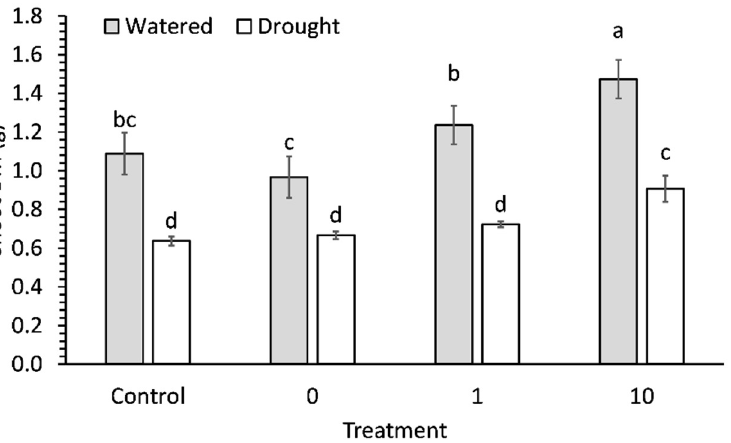
Figure 2. Shoot biomass in 9-week-old broccoli seedlings that were well watered or droughted for 1 week. Each bar represents a mean and error bars represent standard error calculated from 9 replicates. Means with different letters are significantly different ( p < 0.05) as determined by Tukey’s honestly significant difference.